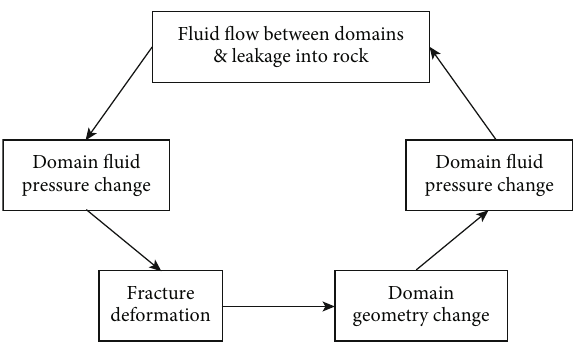
Figure 4: Domain division for fl uid fl ow simulation. Q rate from domain i to domain j ; Q ir , the fl ow rate from domain i to rock matrix.